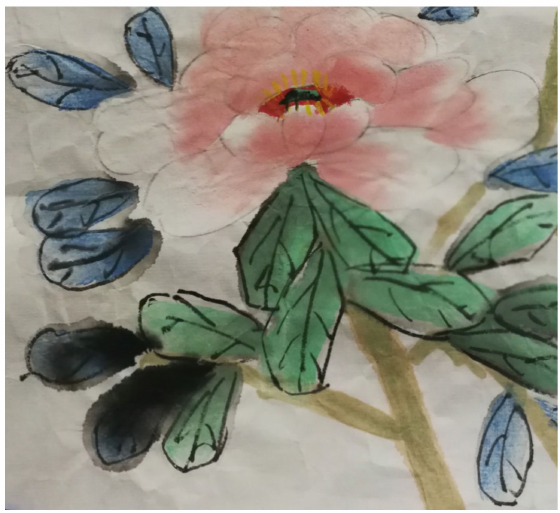
Figure 3. A Chinese painting in true color, which was drawn with several pigments.